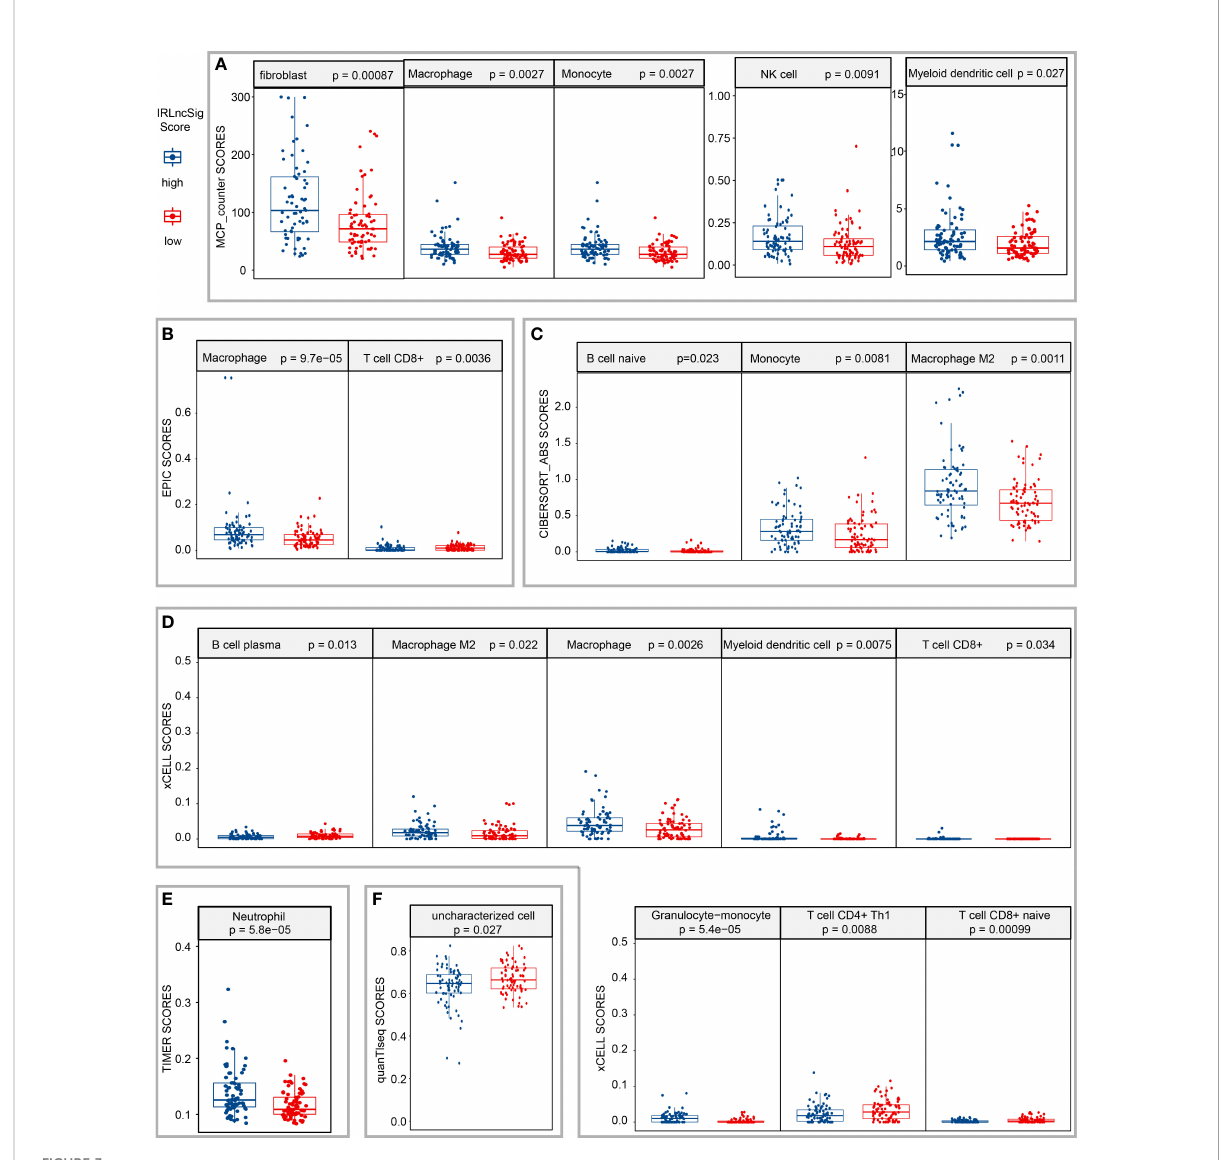
FIGURE 3 Estimation of the correlation between tumor-in fi ltrating cells and the risk assessment model. Wilcoxon signed-rank analysis to calculate the in fi ltration difference of immune cells between low- and high-IRLncSig-scores in different algorithms [ (A) MCP-counter; (B) EPIC; (C) CIBERSORT-ABS; (D) xCELL; (E) TIMER; (F) quanTlseq]. IRLncSig, immune-related lncRNA